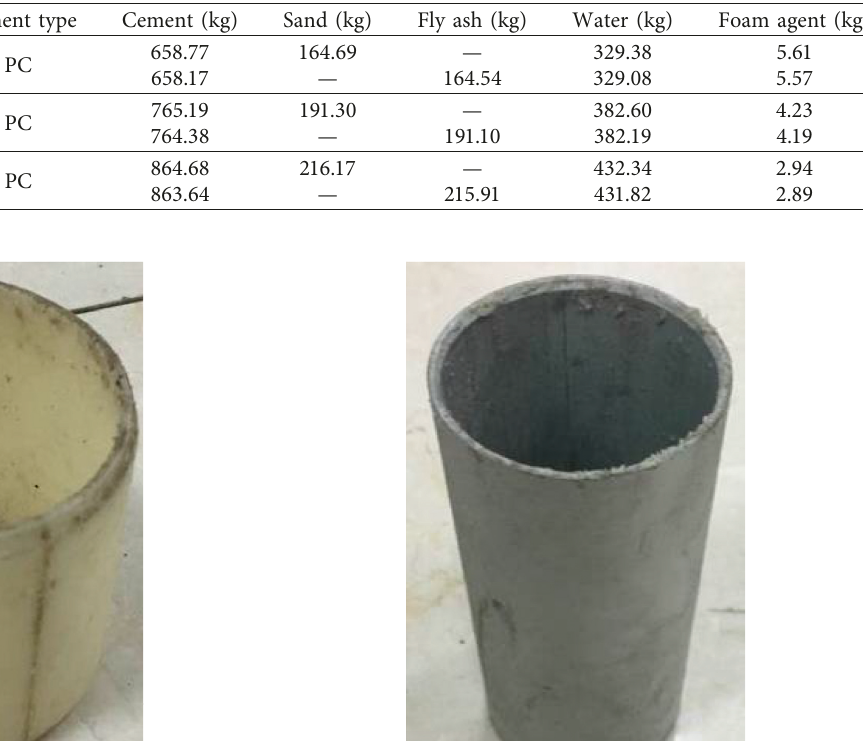
Table 2: Mixing design for foam concrete with different densities (per m 3 ).